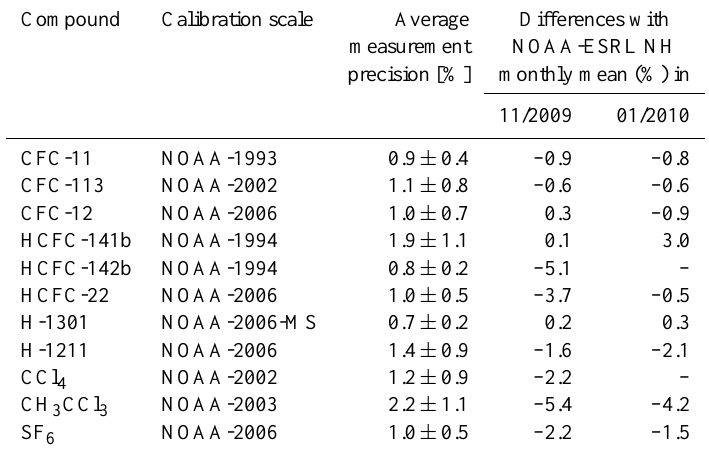
Table 1. Overview of reported compounds, calibration scales, average measurement precisions (including the 1 σ standard deviation of that average), and the percentage difference between mixing ratios observed close to the tropopause and northern hemispheric monthly mean mixing ratios as reported by the ground-based NOAA-ESRL network (except for H-1301; see text).